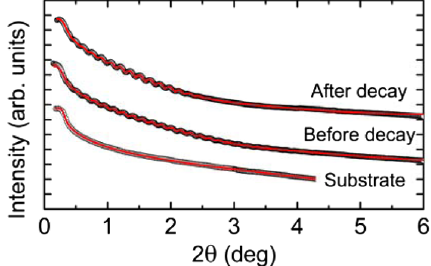
FIG. 5. X-ray reflectivity experimental data (circles) and simulated curves (red lines) of the K-Cs-Sb photocathode at different stages during the beam line experiment. The reflectivity intensity that was measured from the Si substrate, before-decay photocathode and after-decay photocathode, is demonstrated with an offset for clarity.